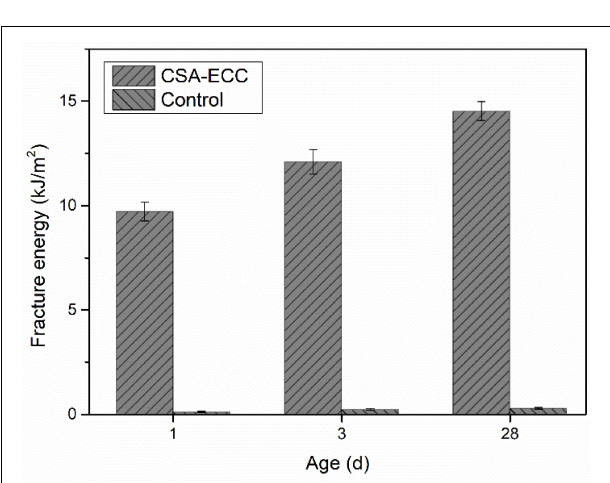
FIGURE 9 | Typical load-deflection curves of the control specimens at 28 d and CSA-ECC specimens after 1, 3, and 28 days of curing.